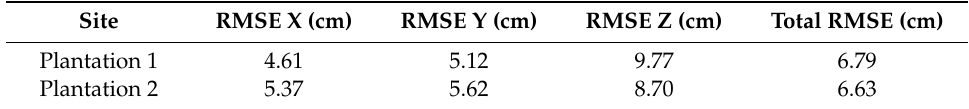
Table 2. Error statistics of checkpoints measured using DSMs. These errors are derived from di ff erencing with checkpoints that serve as a reference. DSMs: digital surface models; RMSE: root mean square